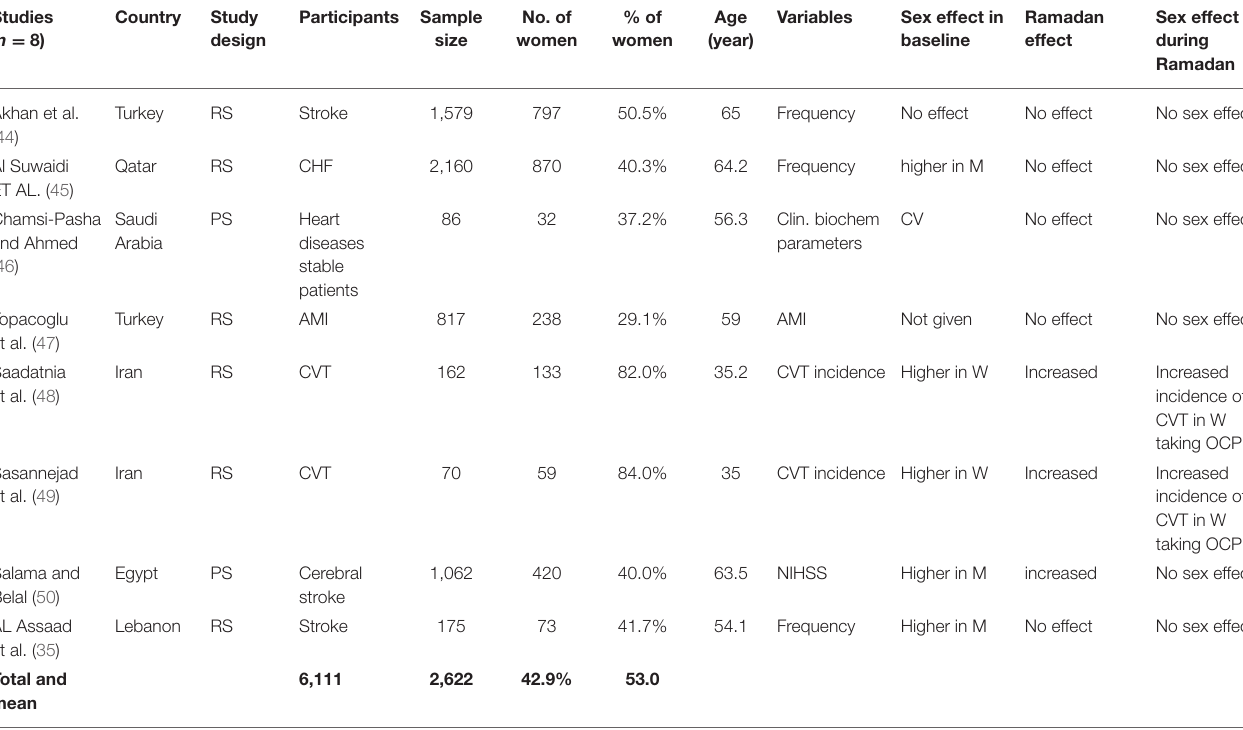
TABLE 5 | Sex differences in outcomes related to cardiovascular diseases in patients during and outside the month of Ramadan. Studies ( n =